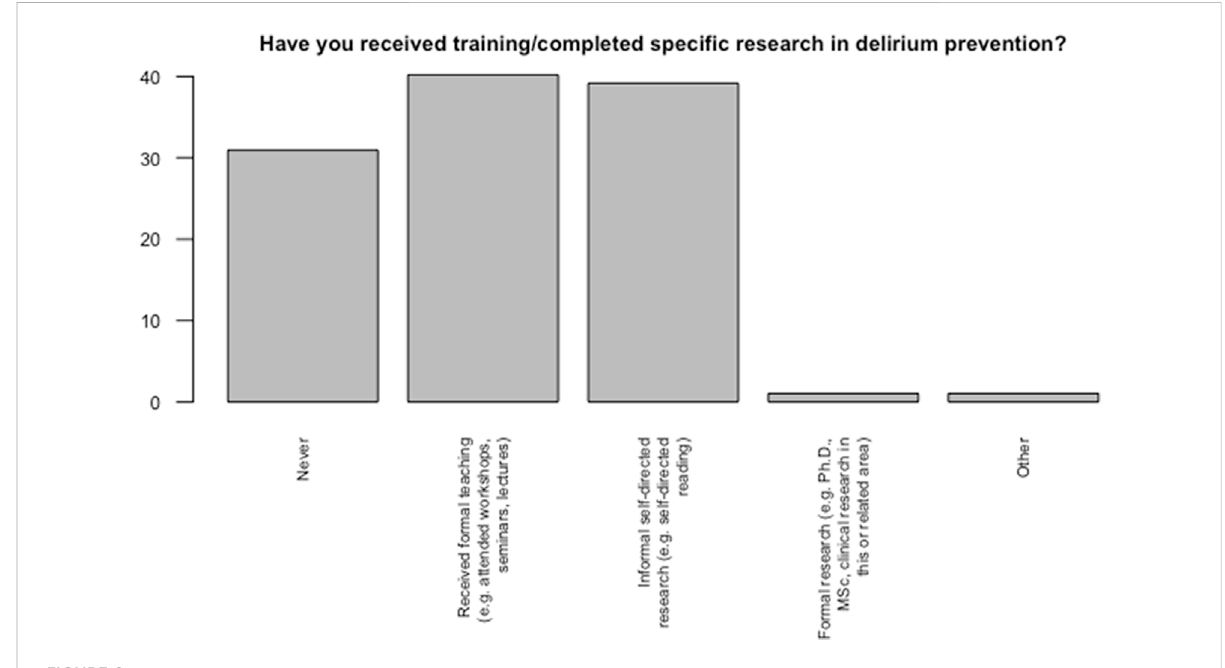
FIGURE 2 Healthcare providers ’ training pertaining to delirium prevention.